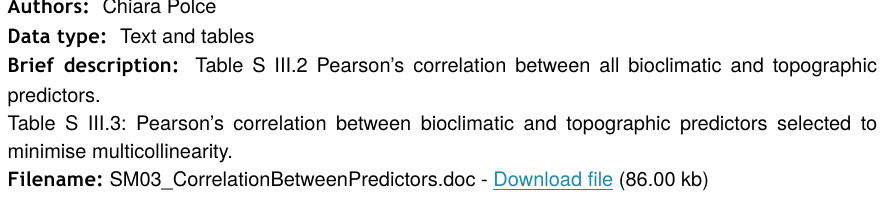
Brief description: Table S III.2 Pearson’s correlation between all bioclimatic and topographic predictors. Table S III.3: Pearson’s correlation between bioclimatic and topographic predictors selected to minimise